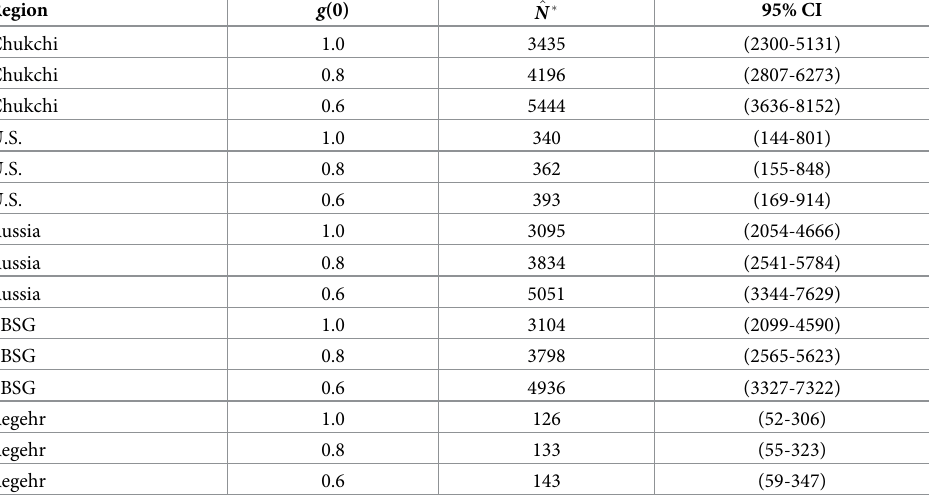
Table 1. Estimates of polar bear abundance for different regions and assumptions about g (0) in Russian survey flights, along with 95% log-based confidence intervals. Regions include the full study grid (‘Chukchi’), mean (i.e., time-averaged) abundance for those cells of the survey grid with centroids in U.S. waters (‘U.S.’), mean abundance in Russian waters (‘Russia’), mean abundance in the portions of our study area that overlapped the polar bear specialist group boundary (‘PBSG’), and an estimate for the area used for capture and release of bears in a mark-recapture study of polar bears in the Chukchi Sea (‘Regehr’ [8]). For a map of the study area and related regions, see Fig 1). Region g